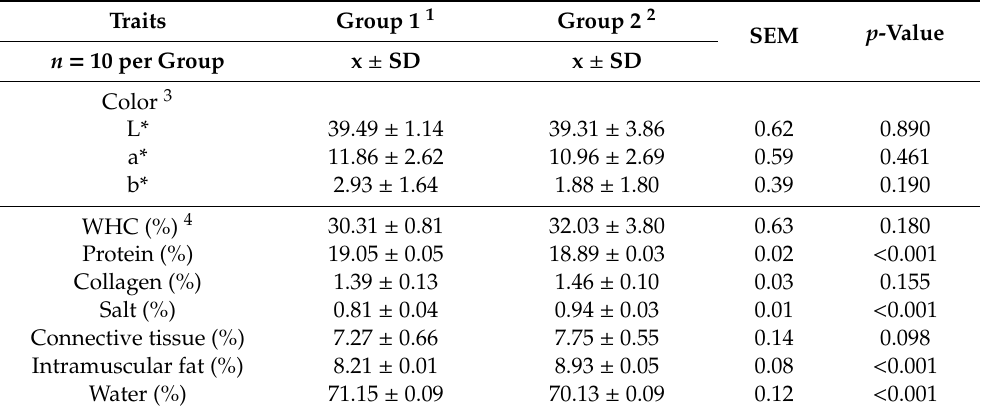
Table 7. Physicochemical parameters of leg muscles (mean; ± SD; SEM) in 16-week-old geese. Traits Group 1 1 Group 2